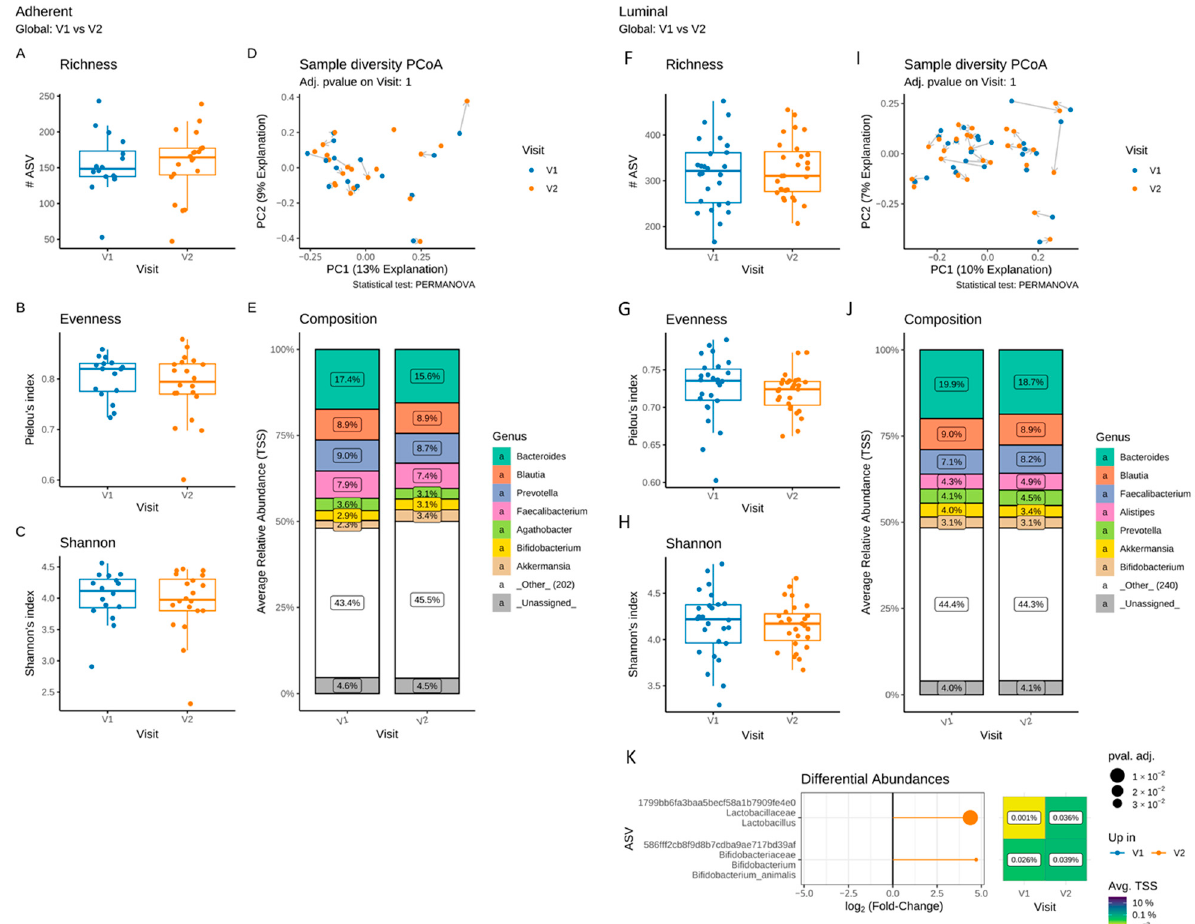
Figure 4. Impact of a 4-week supplementation with the multistrain probiotic on the adherent ( A – E ) and luminal ( F – K ) gut microbiota. ( A – C , F – H ) α -diversity, estimated by the richness (number of observed ASVs) ( A , F ), evenness (Pielou’s index) ( B , G ) and Shannon’s index ( C , H ) at V1 and V2; ( D , I ) principal coordinate analysis (PCoA) of bacterial β -diversity, measured according to Bray–Curtis distance; ( E , J ) bacterial taxonomic profile at genus level before (V1) and after (V2) supplementation; ( K ) differential abundance analysis of the luminal microbiota at the ASV level at V1 and V2. Only significant data are presented as Log2 of the fold of change (FC) according to DESeq2 analysis. Transcription start sites (TSS)